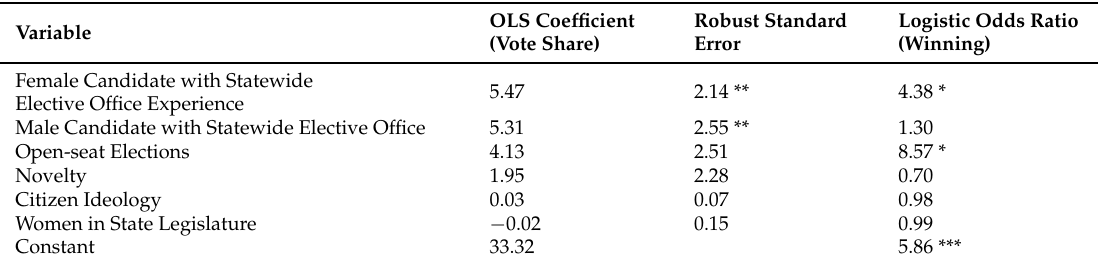
Table 3. Vote for Democratic female gubernatorial candidates running as challengers or in open-seat elections, 1976–2014.